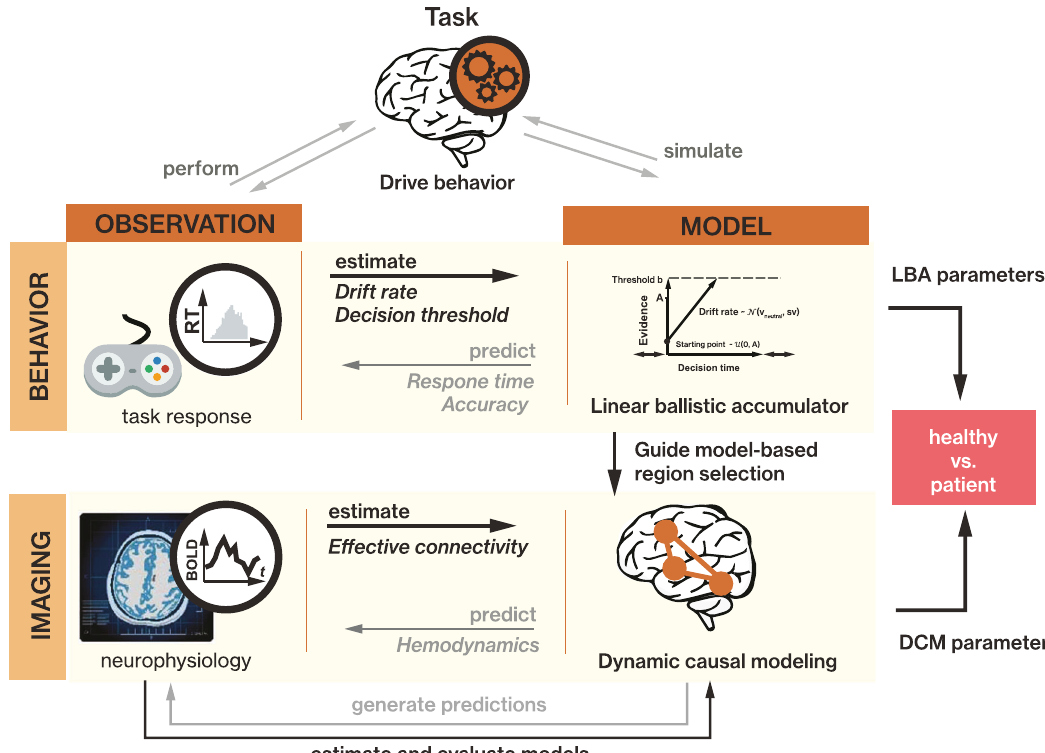
Fig. 2 Analysis pipeline. The analysis harnessed generative models of participants ’ behavior and neural dynamics. The decision components for the face matching task (e.g. drift rate) were used to identify a network of brain regions from which we were able to derive a mechanistic understanding of behavioral differences. These regions were then used to establish a DCM that describes functional coupling within the network circuitry. Statistical inference was performed separately on LBA and DCM